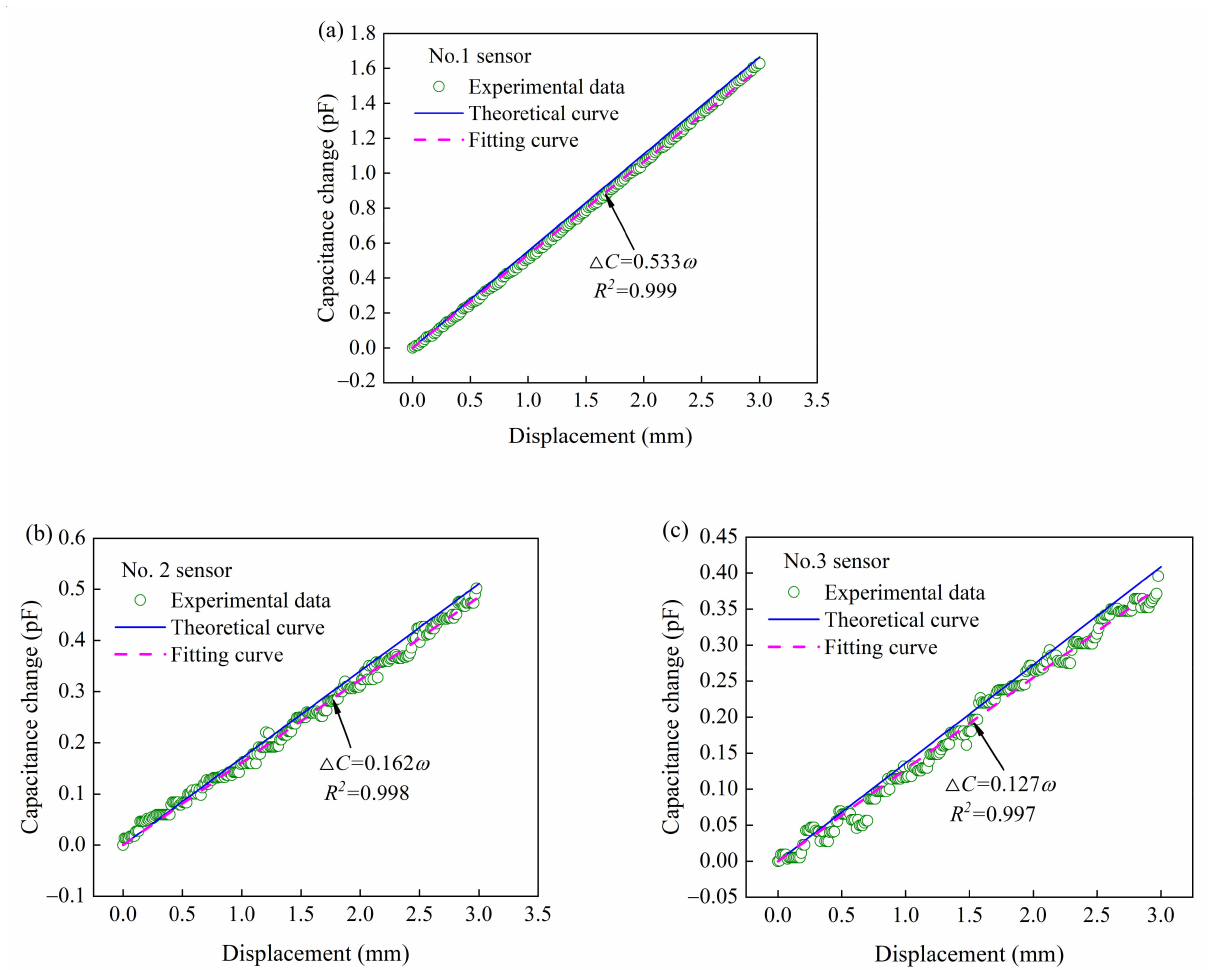
Figure 11. Capacitance change with the displacement applied to ( a ) No.1, ( b ) No.2, and ( c ) No.3